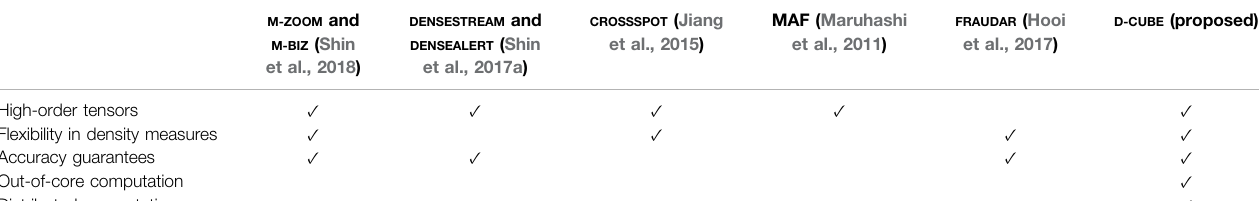
TABLE 1 | Comparison of D-CUBE and state-of-the-art dense-subtensor detection methods. ✓ denotes ‘ supported ’ . M-ZOOM and M-BIZ